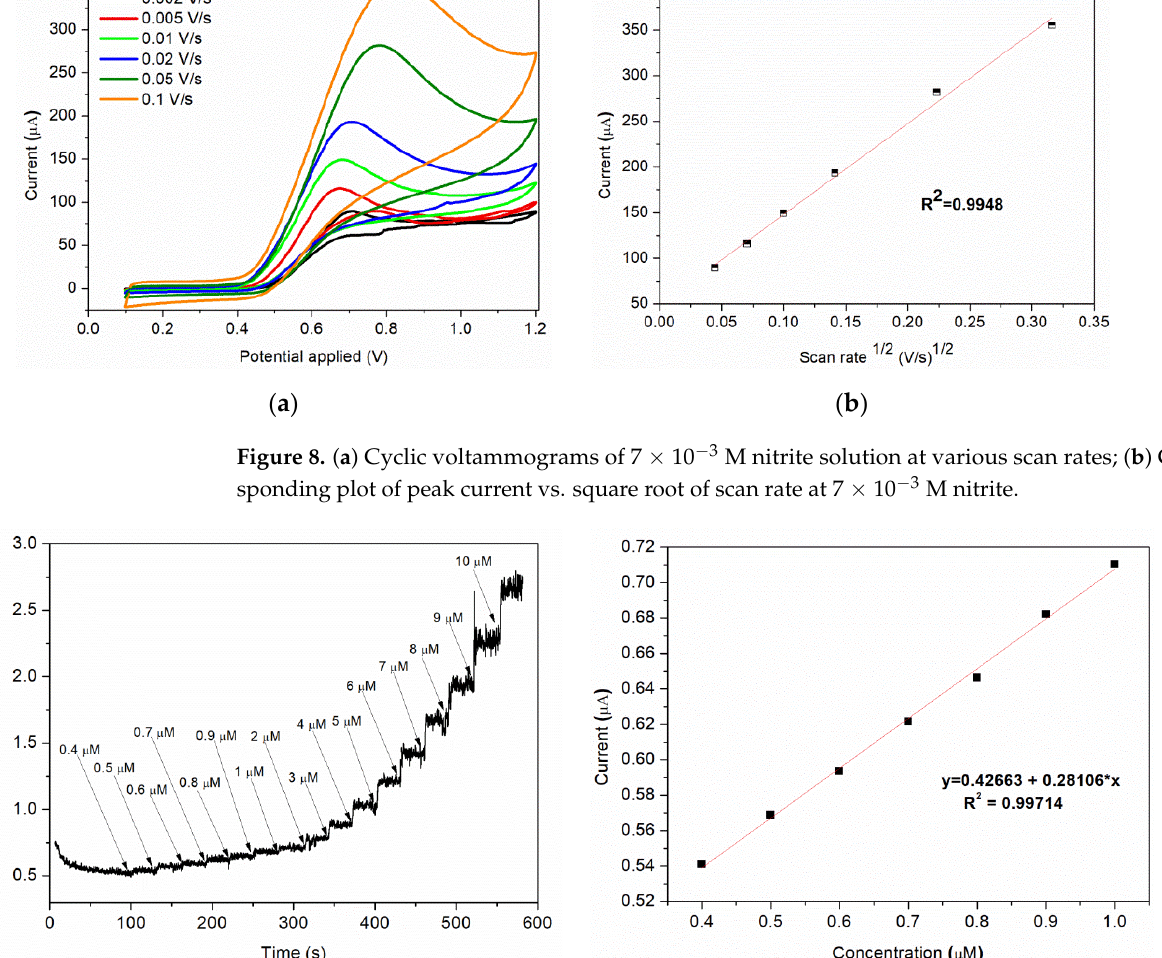
Figure 8. ( a ) Cyclic voltammograms of 7 × 10 − 3 M nitrite solution at various scan rates; ( b ) Corre ‐ sponding plot of peak current vs. square root of scan rate at 7 × 10 − 3 M nitrite.